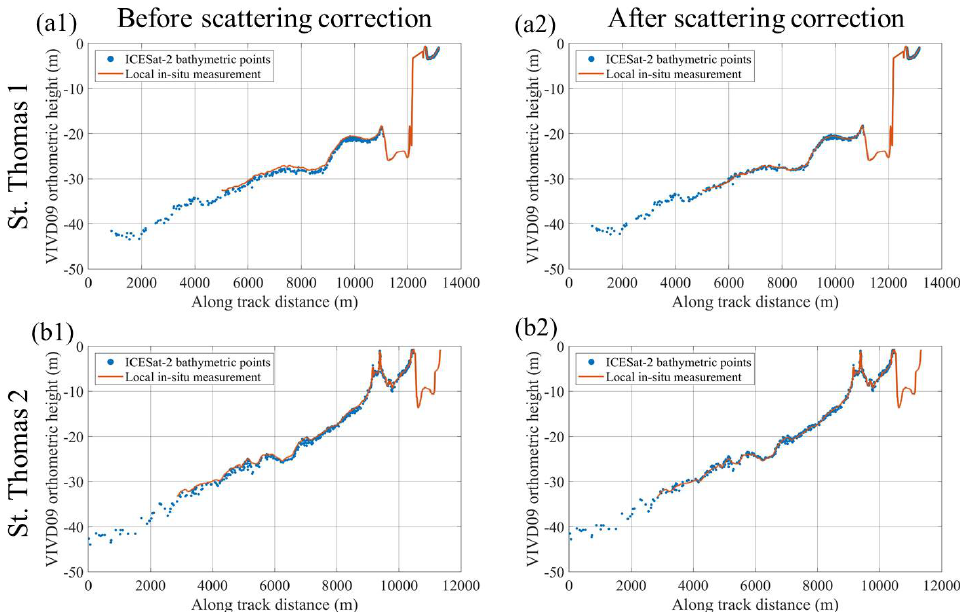
Figure 7. Comparisons between ICESat-2 along-track bathymetric points and truth profiles (calcu- lated from local in situ measurements) at St. Thomas. Two left subfigures ( a1 , b1 ) correspond to ICESat-2 points without water forward-scattering corrections, whereas ( a2 , b2 ) correspond to that with scattering corrections. It should be noted that all height values are in VIVD09 orthometric heights.